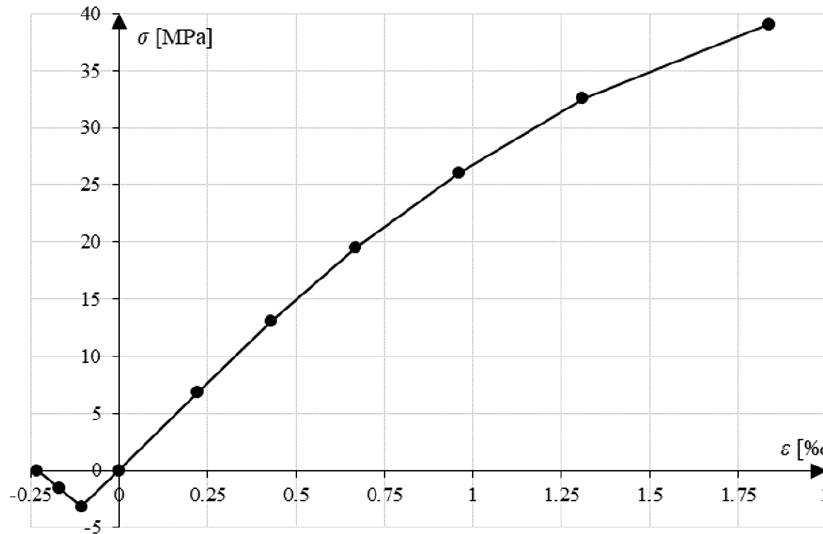
Figure 16: Stress–strain characteristic entered into